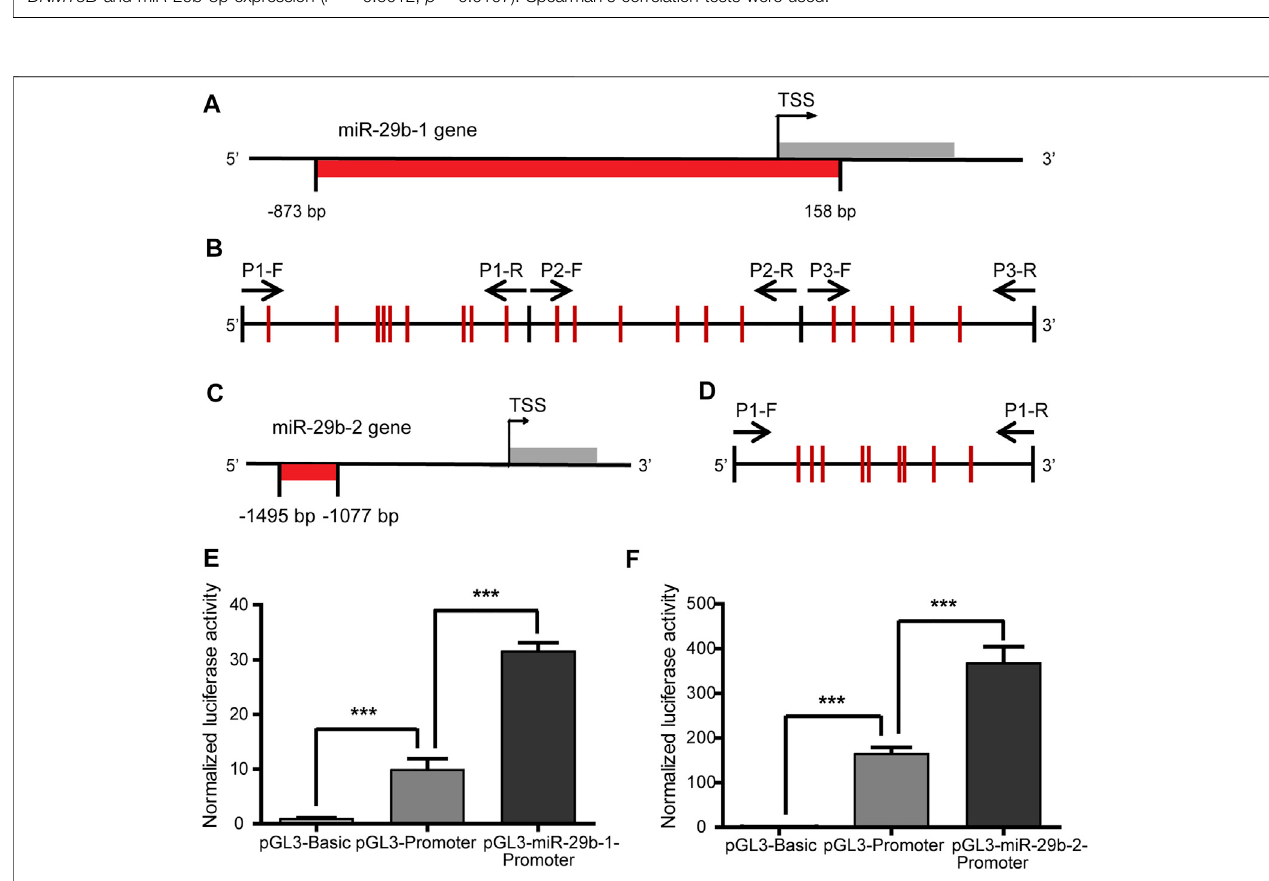
FIGURE2| TranscriptionalregulatoryactivityofthemiR-29b-1andmiR-29b-2genepromoters. (A) ThelocationoftheCpGsitesinthepromoterregionofthemiR- 29b-1 gene ( − 873 bp to +158 bp). (B) The distribution of the CpG sites and three pairs of primers designed for bisul fi te sequencing PCR in the promoter region of the miR-29b-1 gene. (C) The location of the CpG sites in the promoter region of the miR-29b-2 gene ( − 1495 bp to − 1077 bp). (D) The distribution of the CpG sites and the primers designed for bisul fi te sequencing PCR in the promoter region of the miR-29b-2 gene. (E) The effect of the − 873 bp to +158 bp region on the regulation of miR-29b-1genepromotertranscriptionalactivity. (F) Theeffectofthe − 1407bpto-1173bpregionontheregulationofmiR-29b-2genepromotertranscriptionalactivity (*** p < 0.001).